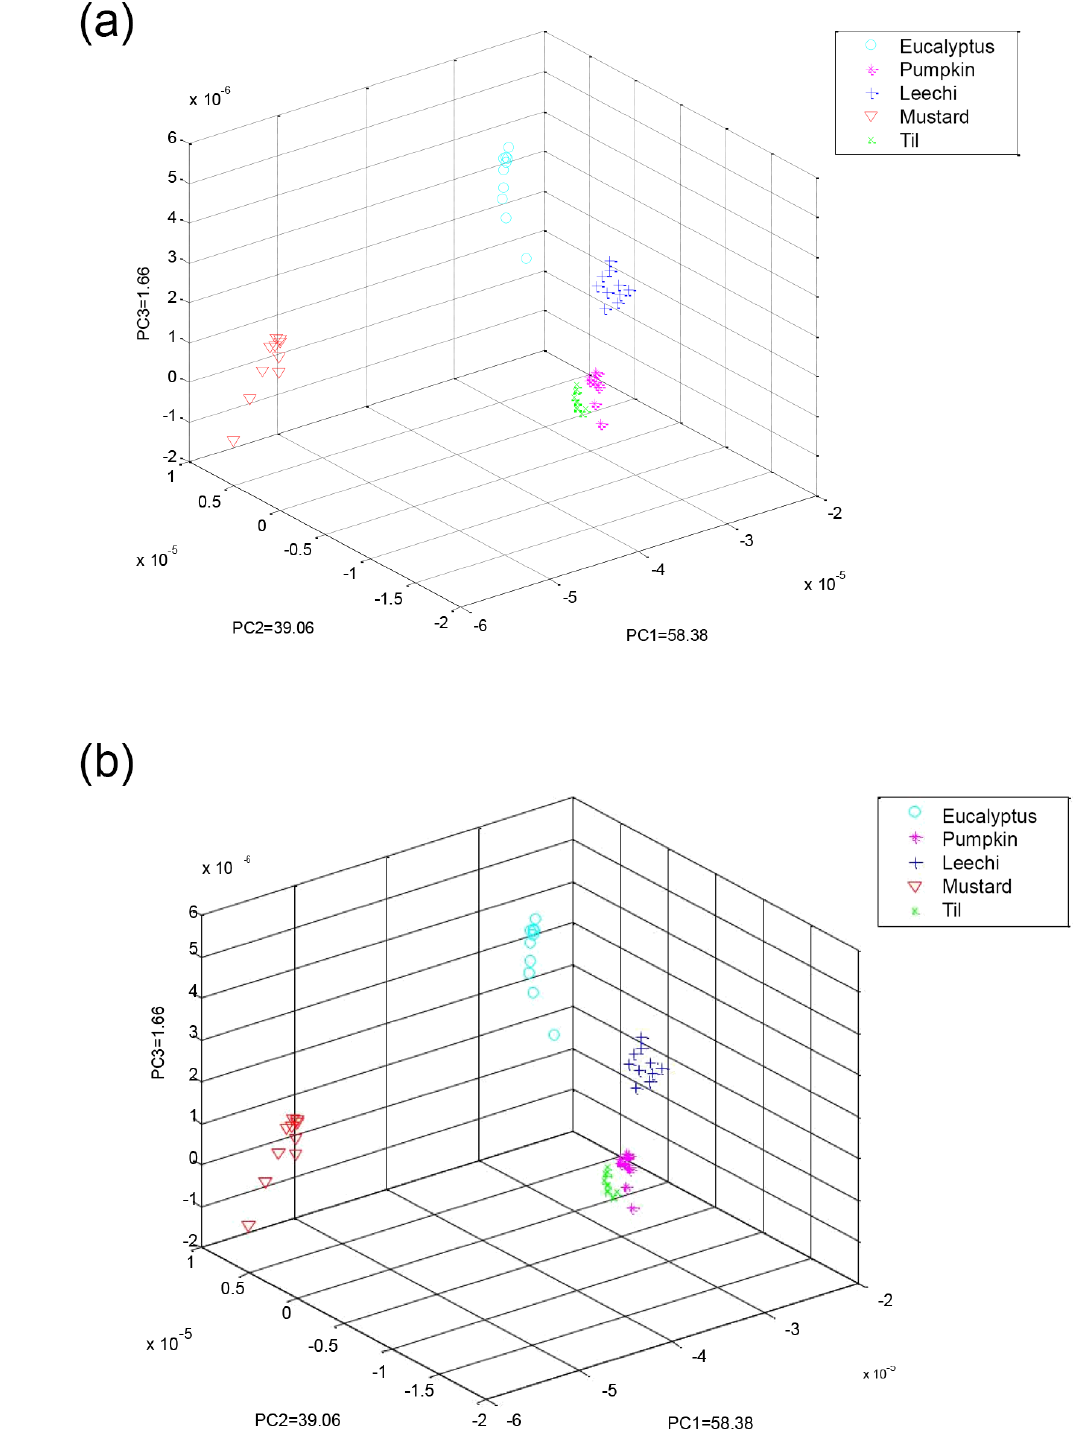
Figure 6. (a) PCA plots of honey samples using a bare CPs electrode; (b) ZnO nanoparticle modified CPs